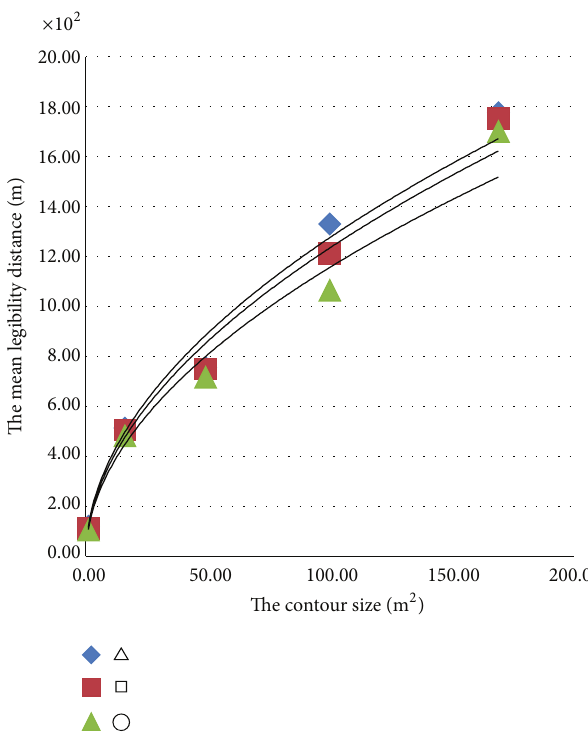
Figure 7: Relationship between the mean legibility distance and the contour size under 120km/h, where the relationship between the mean legibility distance and the contour size under 120 km/h was for triangle: 𝑦 = 119.2𝑥 0.514 and 𝑅 2 = 0.902 , for rectangle: 𝑦 = 112.4𝑥 0.520 and 𝑅 2 = 0.904 , and for round: 𝑦 = 106.4𝑥 0.518 and 𝑅 2 = 0.921 .